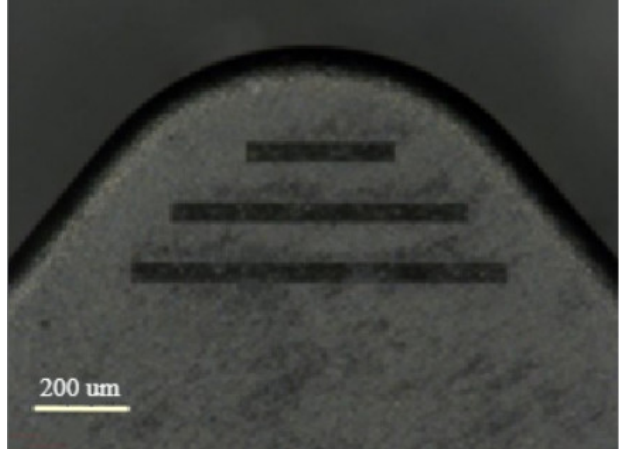
Figure 12. Microgroove texture morphology of rake face.